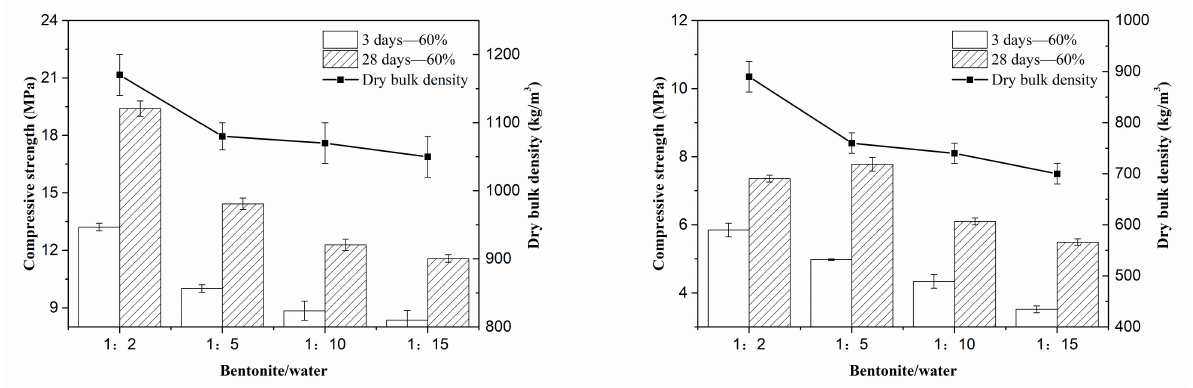
Figure 6. Influence of bentonite-to-water ratio on the compressive strength of porous MOS cement